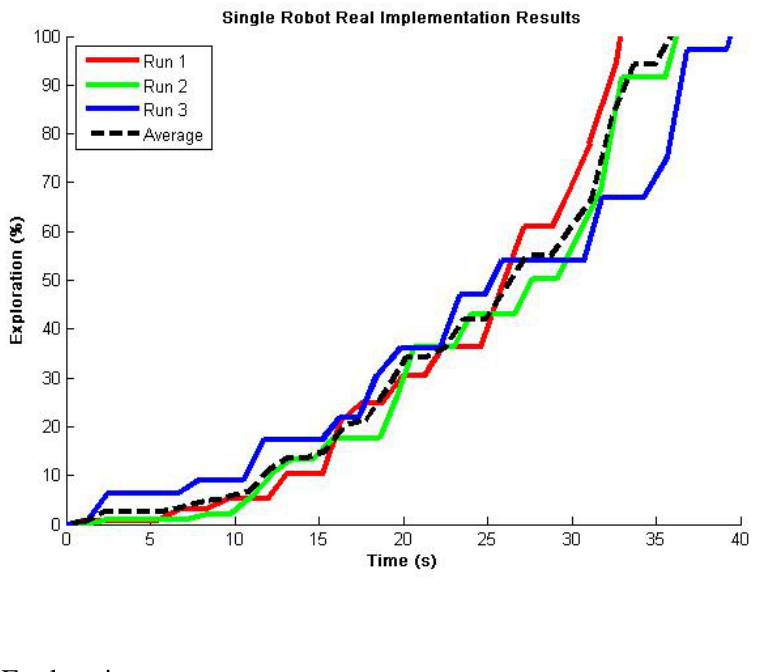
Autonomous exploration showing representative results implementing the exploration algorithm in one Jaguar V2. An average of 36 s for full exploration demonstrates coherent operations considering simulation